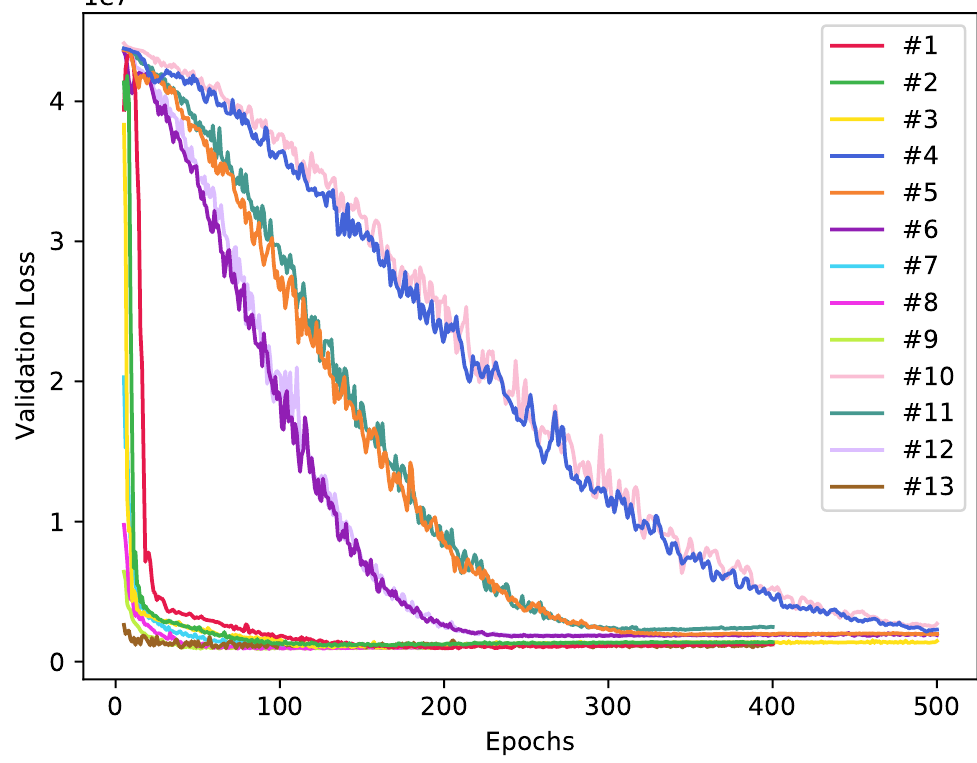
Figure 8. Validation loss over epochs for all